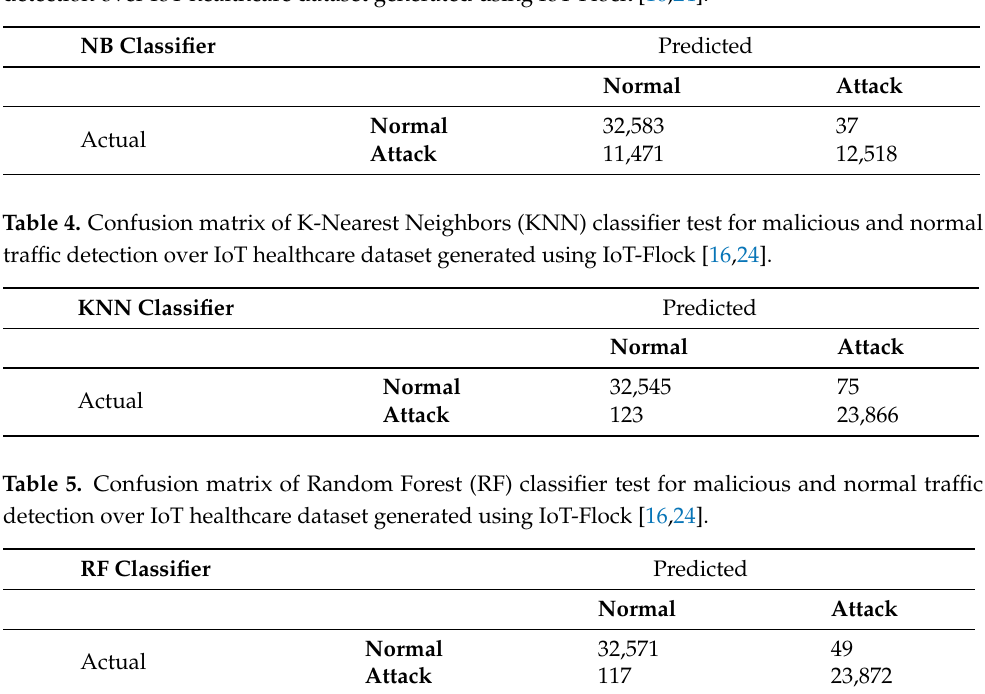
Table 3. Confusion matrix of Naive Bayes (NB) classifier test for malicious and normal traffic detection over IoT healthcare dataset generated using IoT-Flock [16,24].